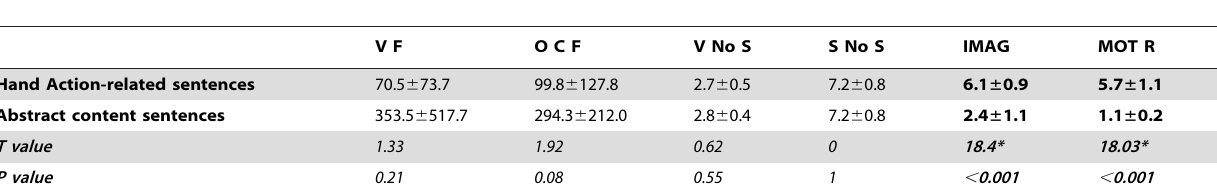
Table 2. List of frequency, length and subjective ratings’ mean values of all